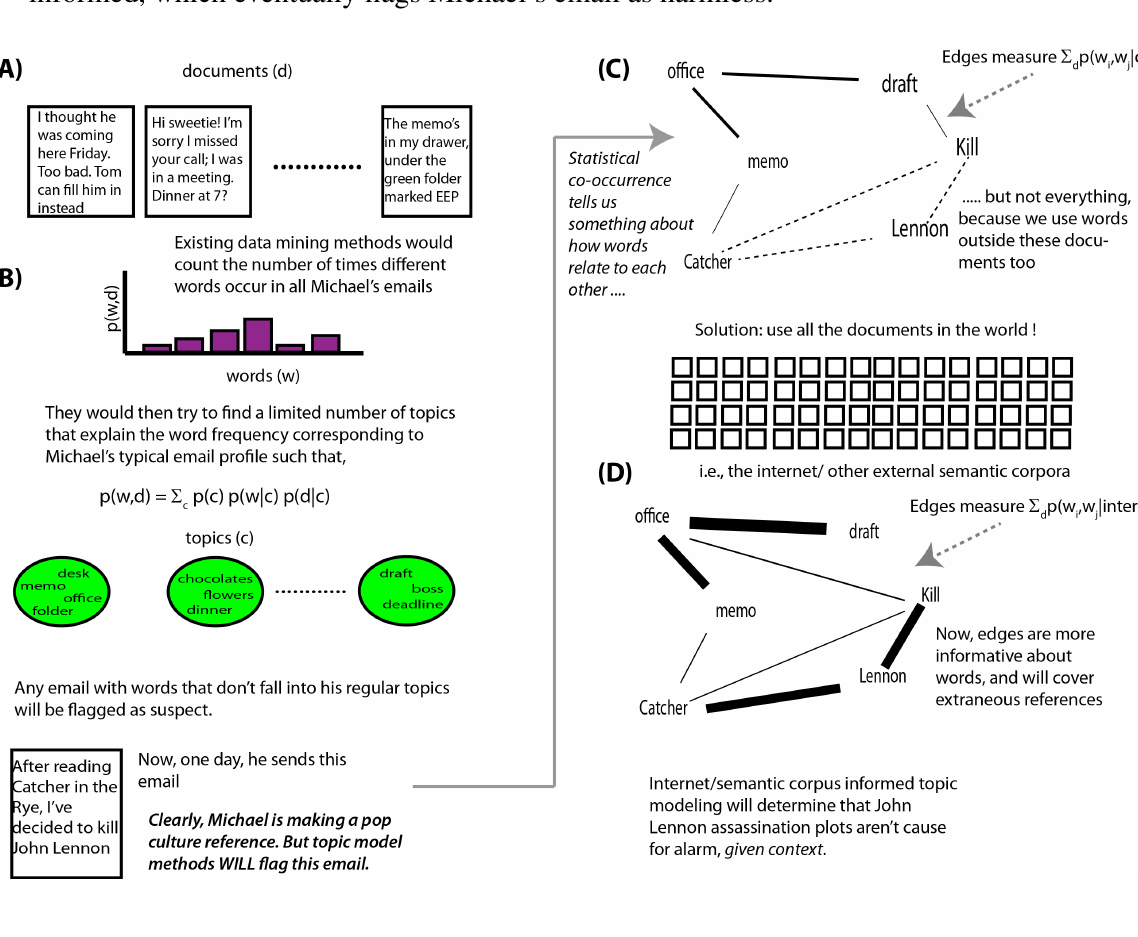
Figure 1. This figure shows a notional application scenario of our algorithm, highlighting its benefits over the state-of-the-art techniques. ( A ) shows a set of emails populating Michael’s inbox; ( B ) (above) shows how the topic models would extract latent themes, based solely on statistical frequencies of word co-occurrences; ( B ) (below) shows that a pop culture reference made by him is flagged anomalous due to the statistical rarity of the used words in the given corpus; ( C ) shows the relational-language graph used by topic models where edges only capture the statistical co-occurrence between the words in the corpus; ( D ) shows the contribution made by us where the edges now also capture the semantic distance between the words tuned over a very large set of external documents and are hence more contextually informed, which eventually flags Michael’s email as